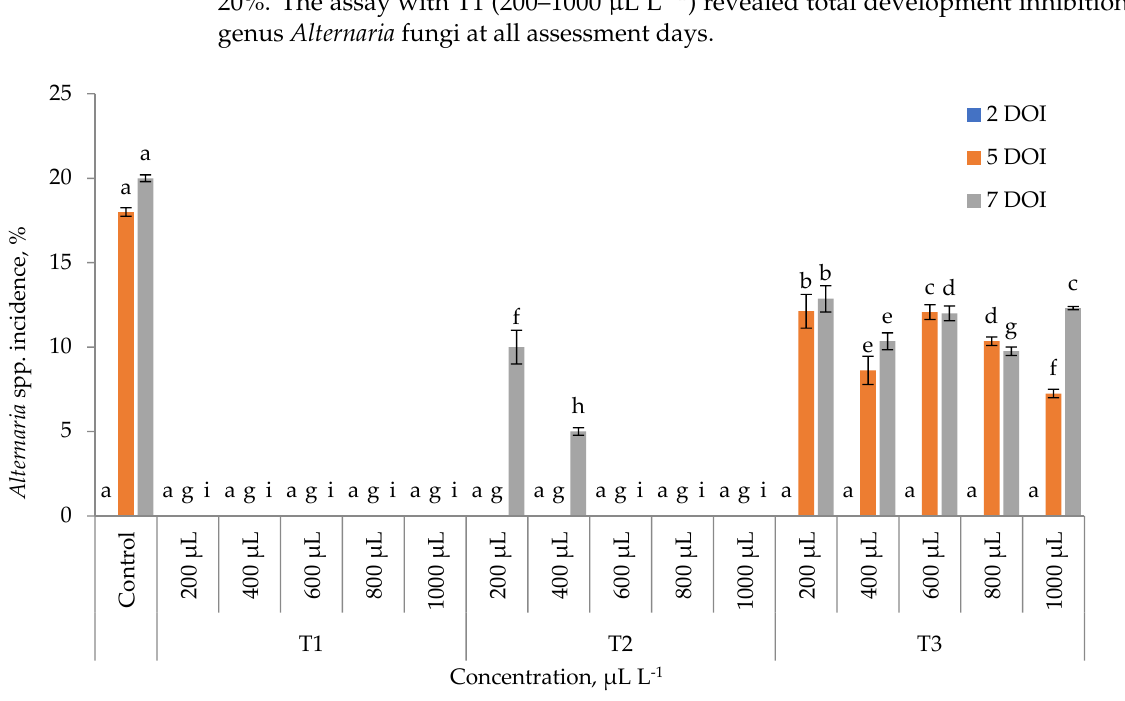
Figure 4. The incidence of Alternaria spp. on onion seeds under the influence of thyme (T1), hyssop (T2), and common juniper (T3) essential oils treatments after 2, 5, and 7 days of incubation (DOI); according to Duncan’s multiple range test ( p < 0.05), the same letters demonstrate no significant differences between treatments at 2, 5, and 7 DOI.